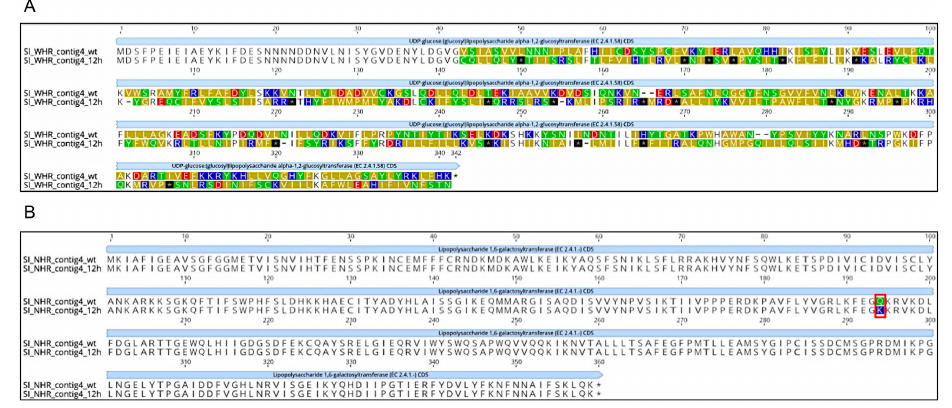
Figure 4. Amino acid alignment of putative receptor in Salmonella Infantis. ( A ) Amino acid alignment of UDP-D-glucose:lipopolysaccharide alpha-1,2-glucosyltransferase (UDP-D-1,2) UDP-D-galactose lipopolysaccharide galactosyltransferase 1,6 (UDP-D-1,6) in wild-type S . Infantis